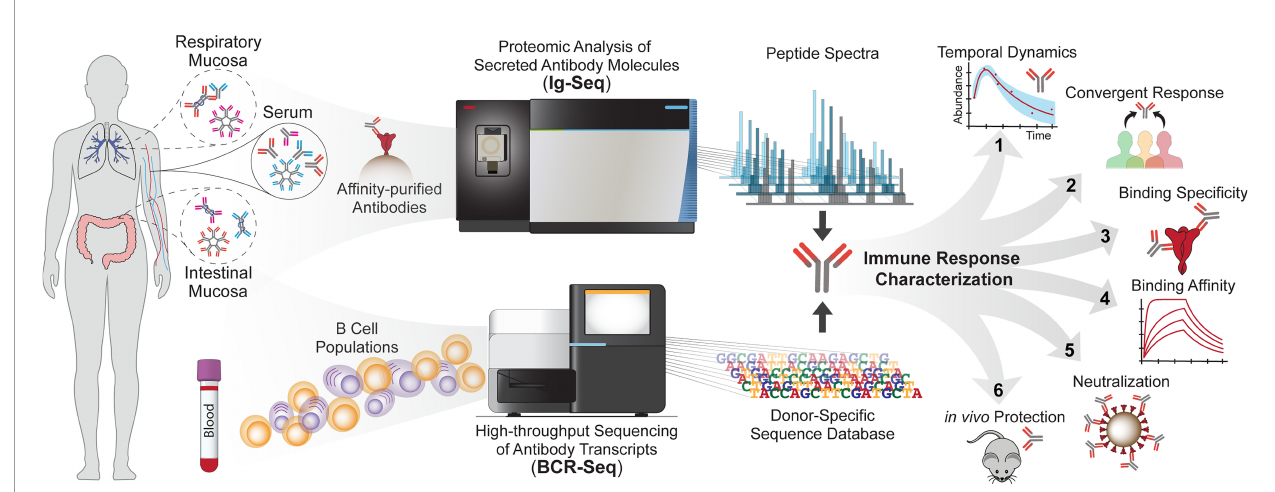
FIGURE 1 | Quantitative and qualitative pro fi ling of antibody repertoires using the Ig-Seq pipeline. Antibodies sampled from biological fl uids are subject to af fi nity puri fi cation against an antigen of interest and pro fi led by mass spectrometry (top pathway). A donor-speci fi c reference database generated from BCR-Seq (bottom pathway) is used to match peptide spectra with antibody sequences. Relative antibody abundances are pro fi led in detail and can be tracked longitudinally. Ig-Seq enables detailed longitudinal pro fi ling of antibody repertoires (1), identi fi cation of convergent responses (2), functional characterization of antibody speci fi city (3) and af fi nity (4), as well as delineation of the in vitro neutralization (5) and in vivo protection (6) conferred by abundant antibodies. Insights from the repertoire ’ s behavior after antigenic exposure, and the protective features of expressed mAbs, inform the design of diagnostics, vaccination strategies, and